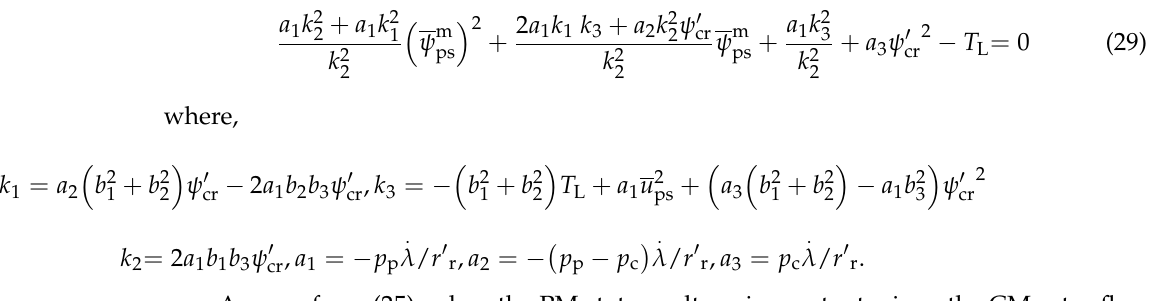
Table 1. BDFM Experimental parameters